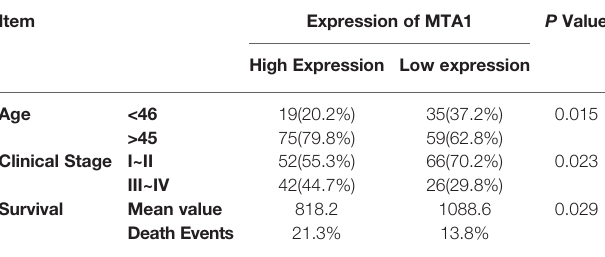
TABLE 2 | The expression of MTA1 in luminal-b breast cancer